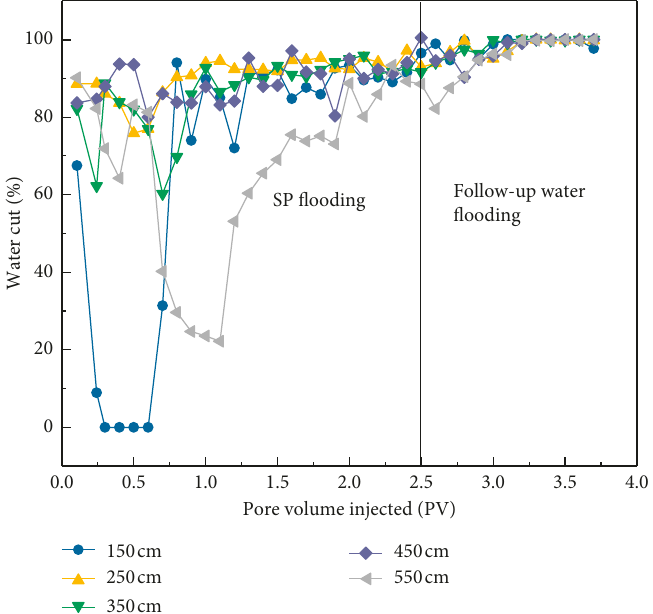
Figure 3: Variation of water cut with pore volume at sampling points.